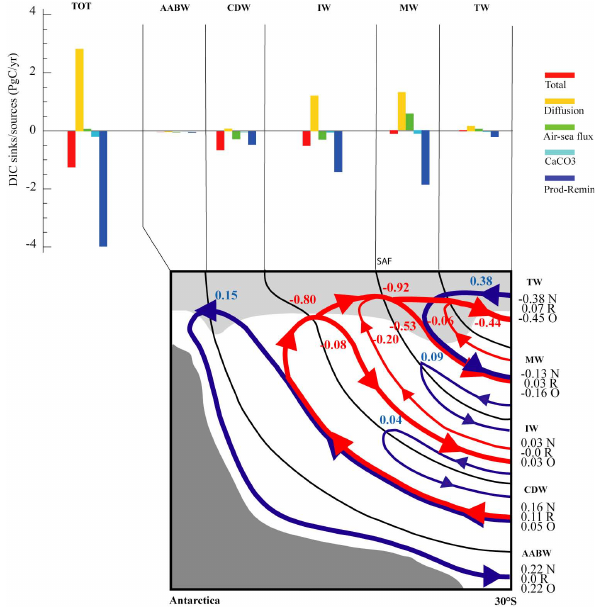
Fig. 8. Upper panel: the same budget as in Fig. 7 but for the up- per 120m. Lower panel: DIC sources/sinks associated with the different branches of the overturning circulation (PgCyr − 1 ), i.e., the same as in Fig. 7. The numbers along the vertical column cor- respond to: the gain/loss of DIC when the water mass leaves the Southern Ocean at 30 ◦ S (N), the gain/loss of DIC for the recircula- tion (R); and the gain/loss of DIC for the overturning. At the surface there are the air-sea CO 2 fluxes (PgCyr − 1 ) for each water mass computed considering the winter density while in parenthesis are the flux computed without considering the winter density. The light blue arrows indicate the fluxes toward the ocean while the magenta arrows indicate the fluxes toward the